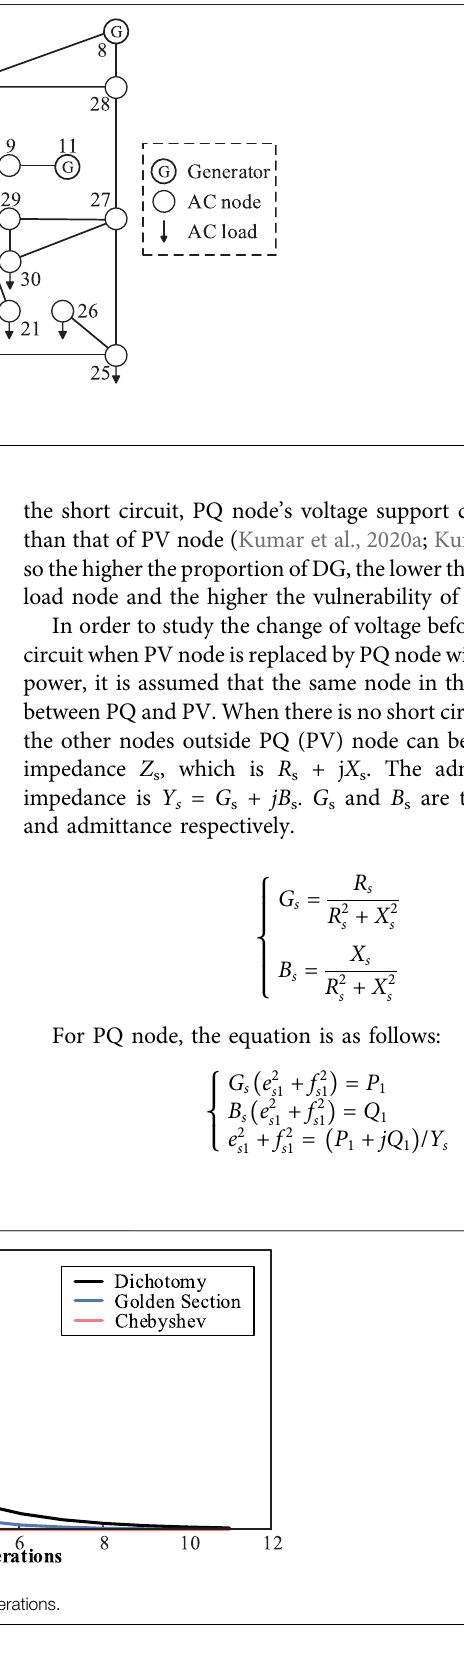
Frontiers in Energy Research |